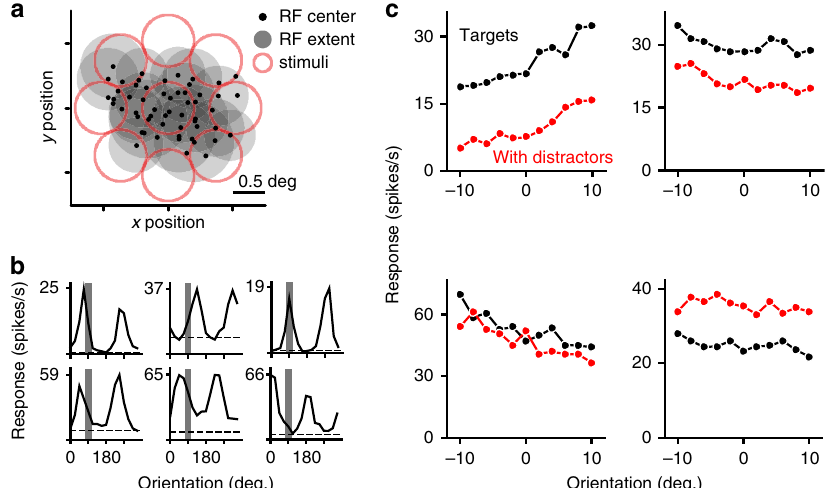
Fig. 2 Experimental approach for V1 physiology. a RFs of each neuron were mapped using small gratings. Black dots indicate RF centers for all neurons in one example recording; shaded gray circles indicate RF size for a subset of neurons, de fi ned as 2 SDs of a Gaussian function fi t to the responses. Red shading indicates the location of the target (center) and distractors. b Orientation tuning of example neurons. Shaded gray bars indicate the range of target orientations presented. Black dashed lines indicate spontaneous rate. c Responses of four example neurons to isolated targets of different orientations (black) and to those same targets when surrounded by distractors (red). Units are different from those shown in b target orientations presented (Fig. 3d; Pearson correlation, r = − 0.68, p = 0.002). When the sampled population was informative